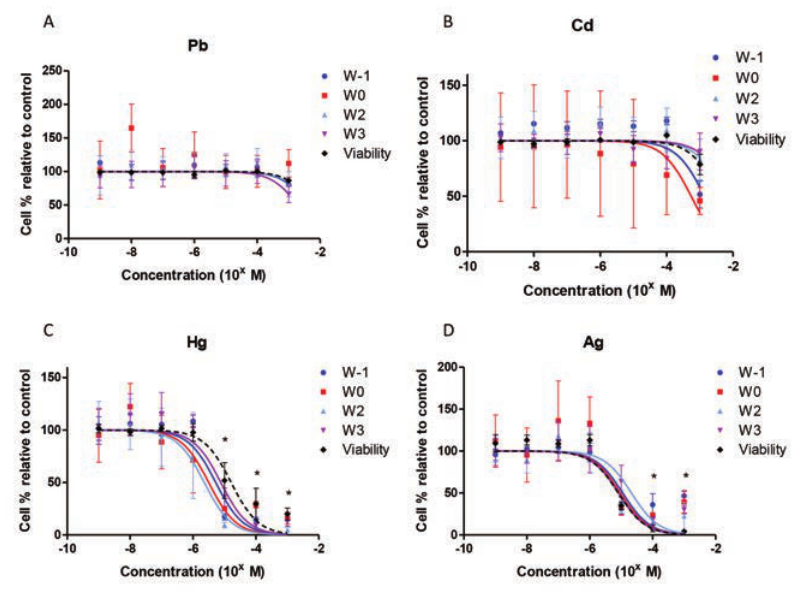
Figure 2. Phagocytic capacity and viability of hemocytes exposed to metals [A: lead (Pb), B: cadmium (Cd), C: mercury (Hg) and D: silver (Ag)] from Mytilus edulis in or out spawning period. Mussels were sacrificed one week before (W-1) spawning, during (W0) spawning, two and three weeks after spawning period (W2 and W3, respectively). Controls were not exposed to metals. To compare difference between concentrations: *ANOVA/Kruskal-Wallis recovery is observed 8 days after the Table 1. Inhibitory concentrations (IC50) of phagocytic capacity of hemocytes exposed to metals in or out spawning period (expressed in 10^x M). Pb